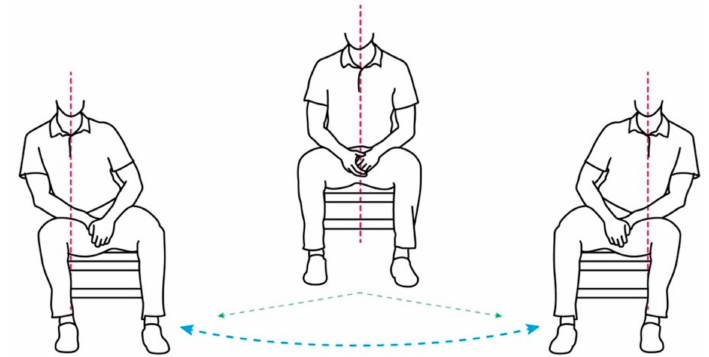
Figure 6. A demonstration of the lower back stretch involved in